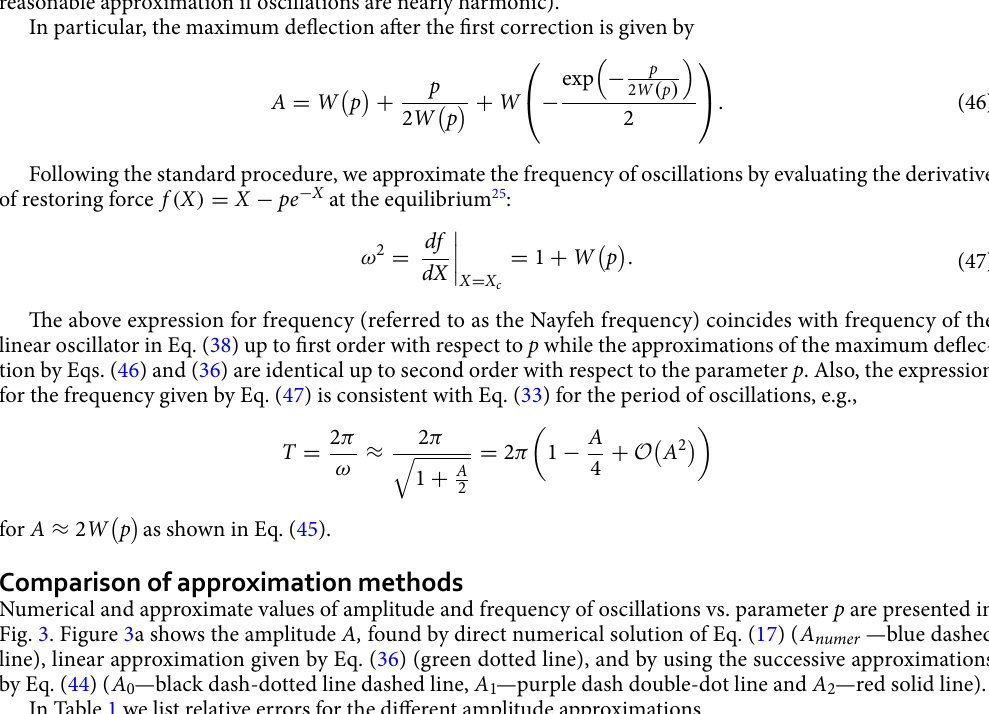
for two different values of parameter p